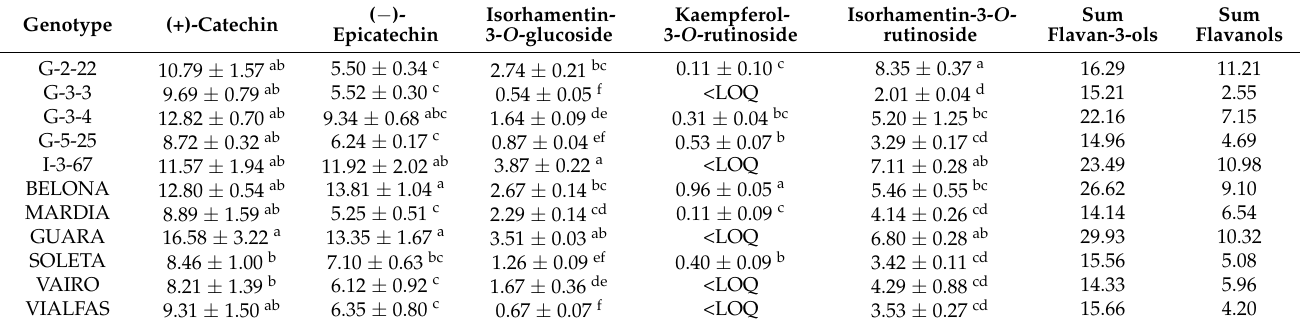
Mean ± standard error in mg/100 g fw ( n = 3). Different letters show statistical significance ( p ≤ 0.05) between different samples.